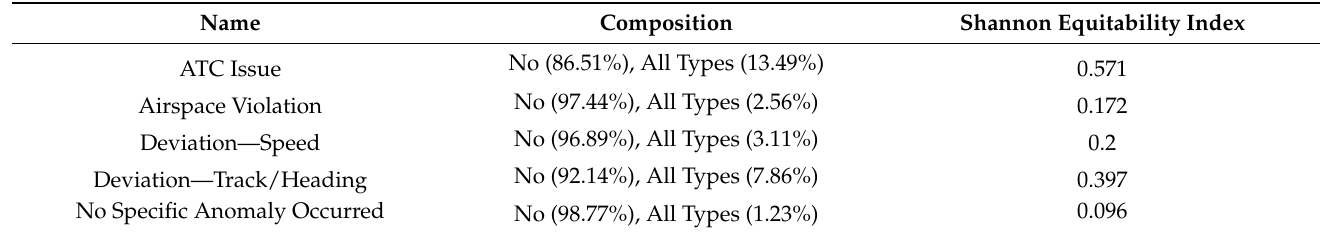
Table 2. Anomaly subcategories that are binary classification